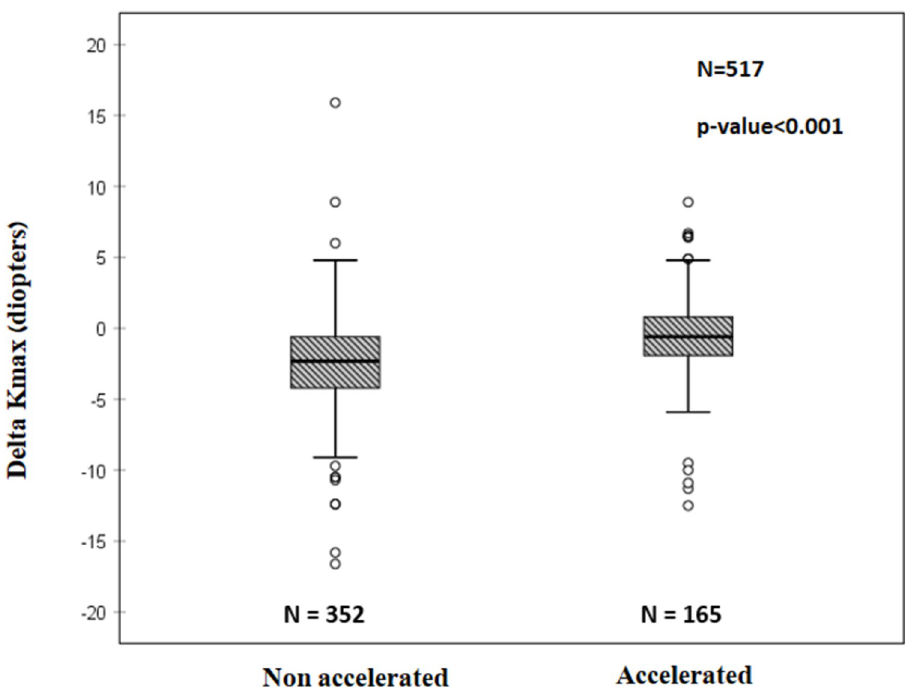
Fig 2. Delta Kmax 1 with non-accelerated and accelerated CXL 2 protocols. Paired t-test showed significantly more mean negative Delta Kmax values with the non-accelerated compared to the accelerated protocol (P < 0.001), indicating a greater efficacy for the non-accelerated protocol. 1 Delta Kmax = (maximal corneal power after cross- linking)–(maximal corneal power before cross-linking). 2 CXL = Cross-linking.